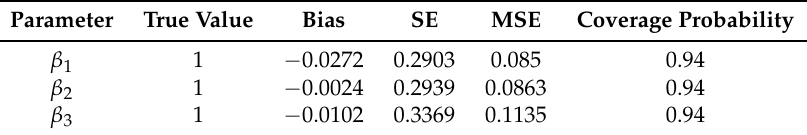
Table 1. Estimation performance.